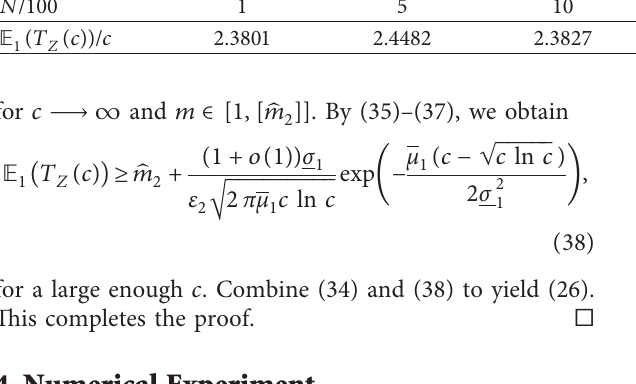
Table 2: Ratios of E